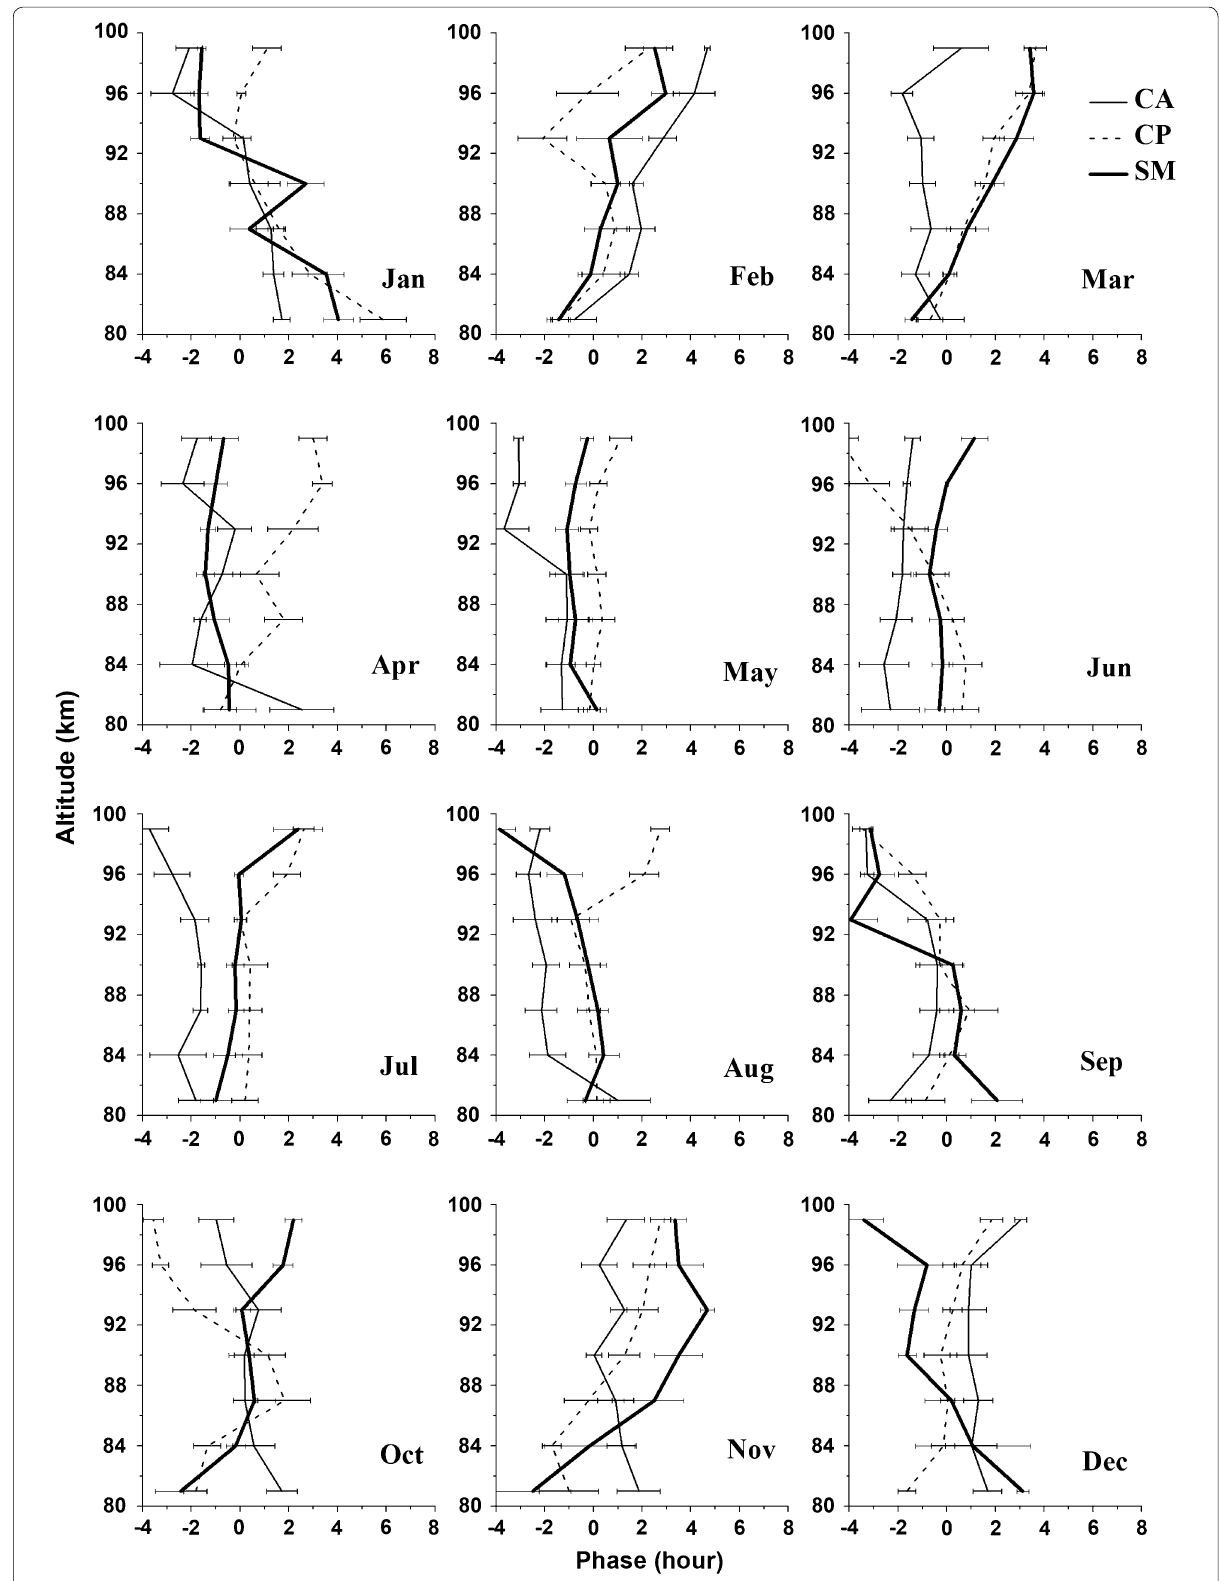
Fig. 9 Same as Fig. 8, but here it is shown for the meridional